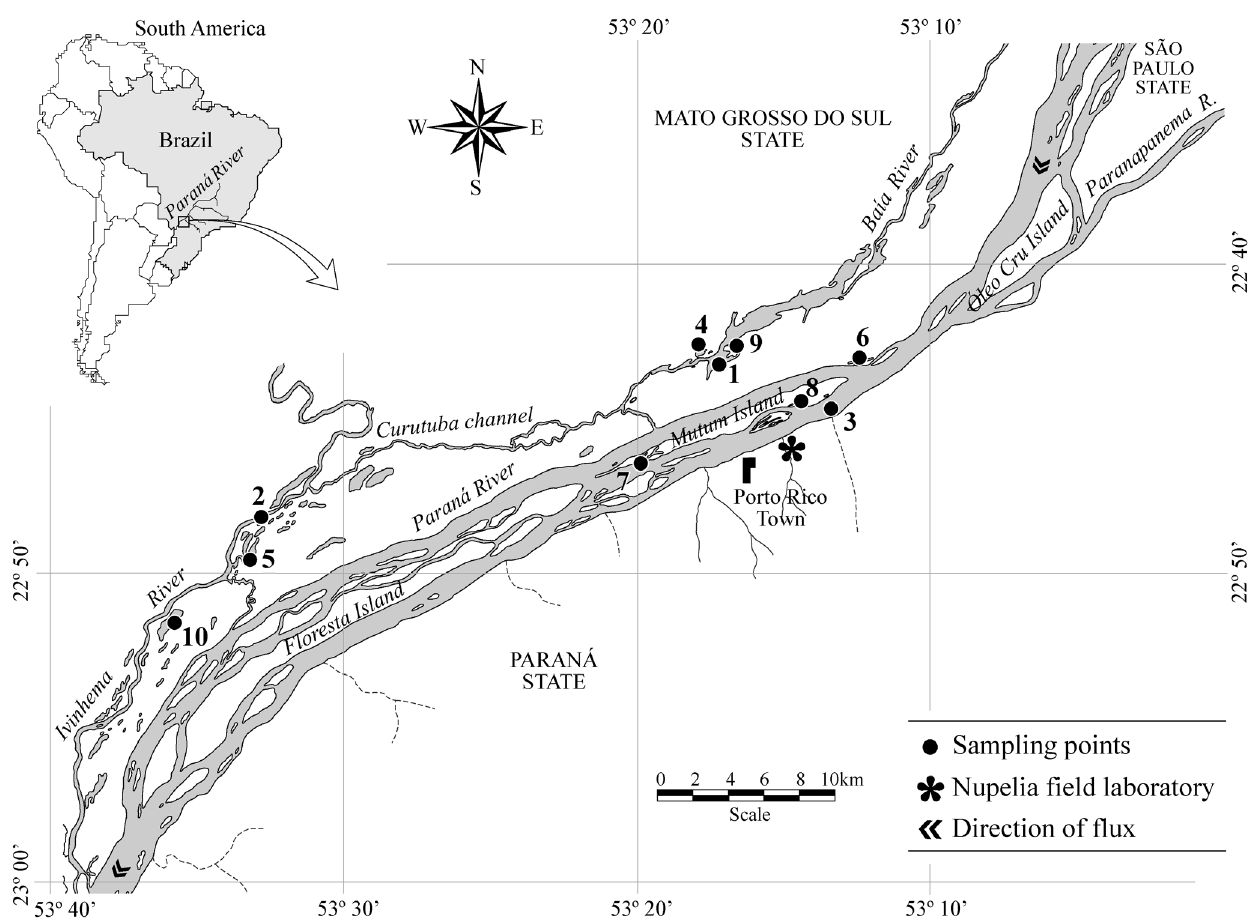
Fig. 1. Study area and location of sampling sites in the floodplain of the Upper Paraná River (Baía River – 1; Ivinhema Ri